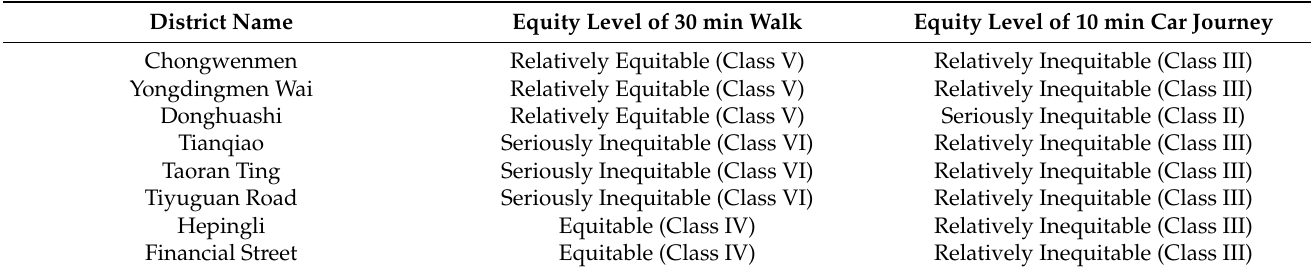
Table 9. Districts with large differences based on 30-min walk and 10-min car